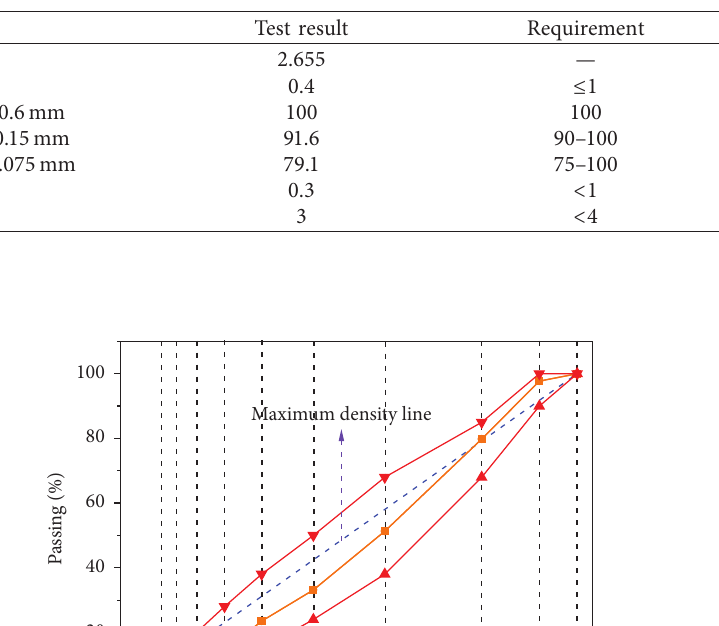
Table 3: Properties of the limestone filler.